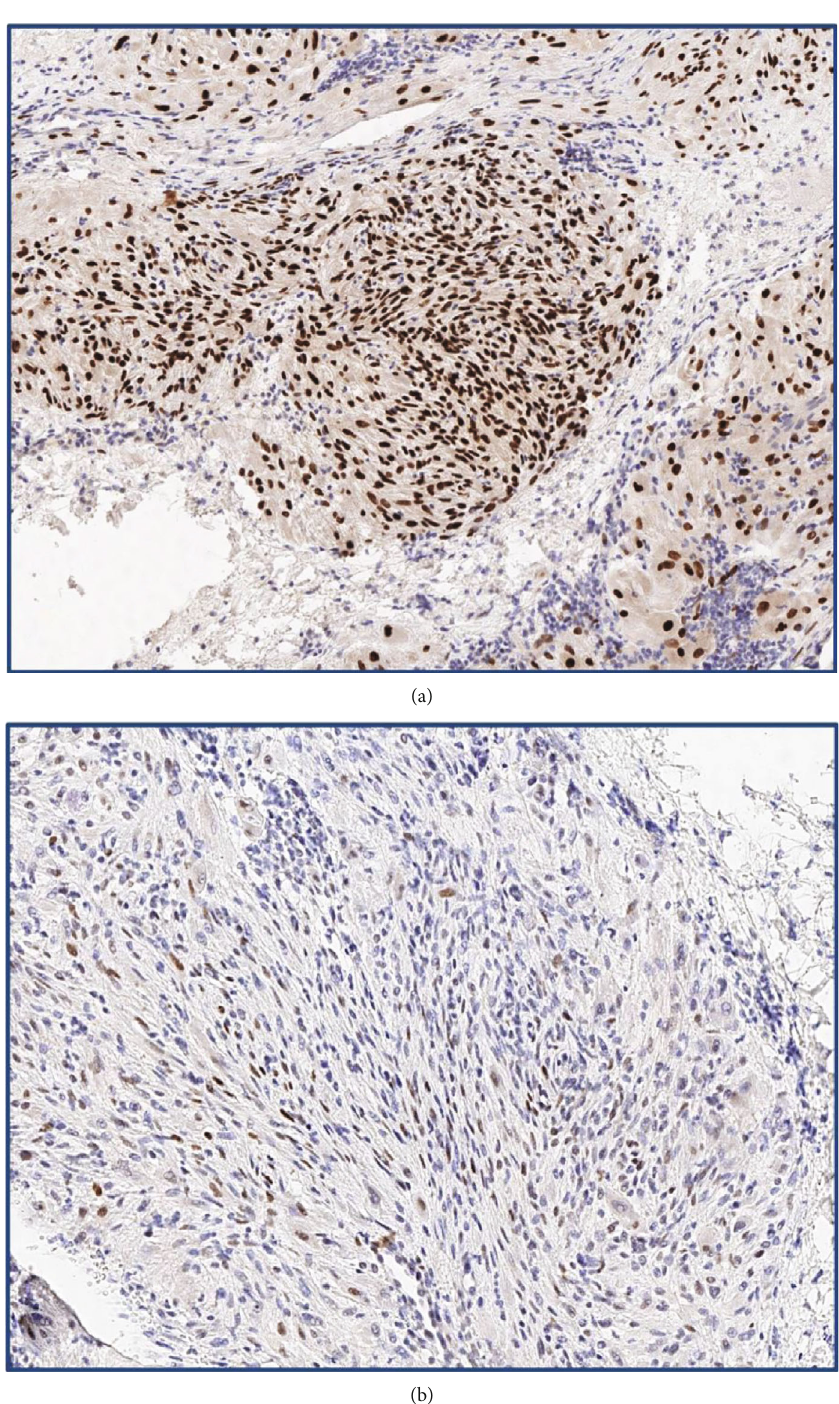
Figure 3: (a) The di ff use nuclear PR expression in decidually transformed cells (magni fi cation × 400). (b) The mild nuclear ER expression in decidually transformed cells (magni fi cation × 400). PR: progesterone receptors; ER: estrogen